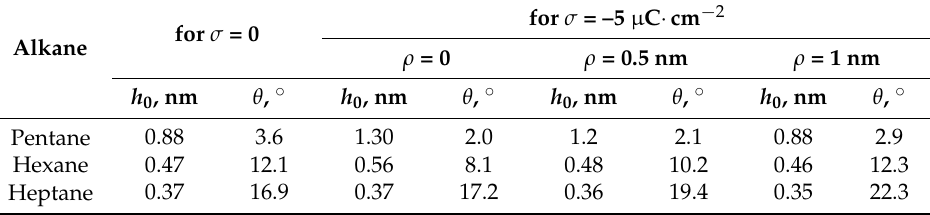
Table 2. Equilibrium film thicknesses and the contact angles, calculated using Equation (16) and isotherms of the disjoining pressure presented in Figure 4, for films of different alkanes on a water